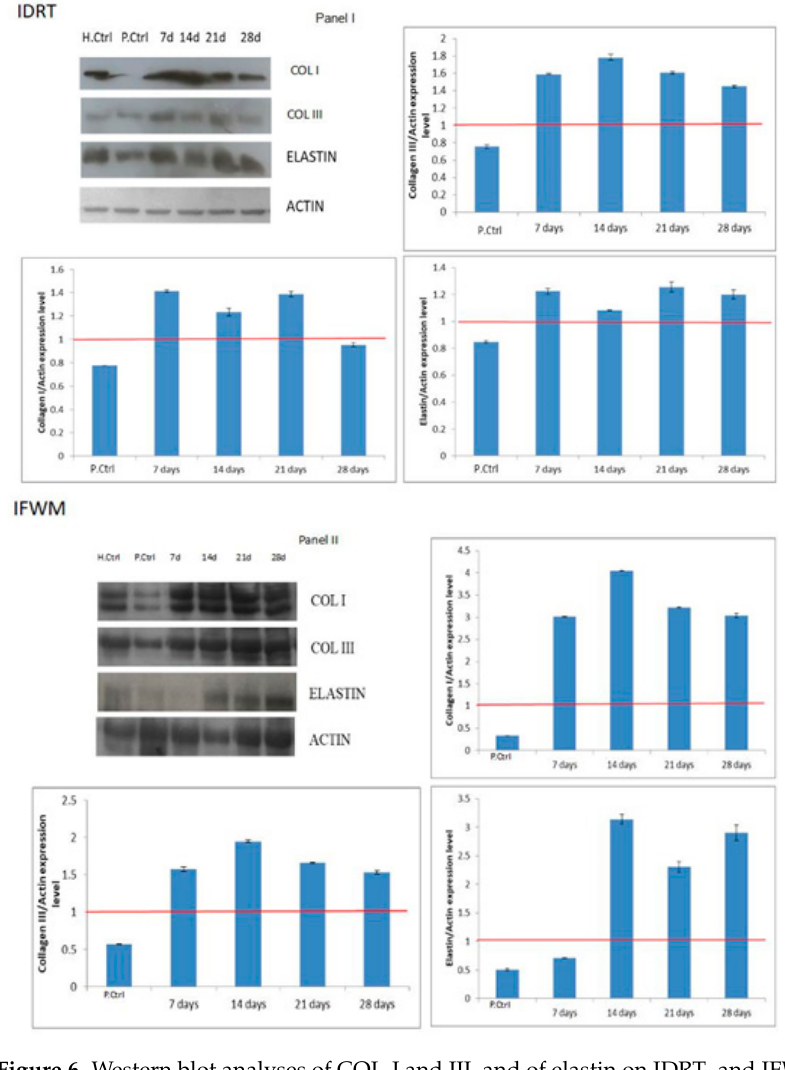
Figure 6. Western blot analyses of COL-I and III, and of elastin on IDRT- and IFWM-treated lesions during the post-surgical follow-up and relative controls. ( Panel I ) Western blot analyses on IDRT- treated lesions at different post-surgical time points, and on relative controls. H.Ctrl (Healthy Control) represents the sample withdrawn in the healthy part of the skin. P.Ctrl (Pathological Control) represents the sample withdrawn in the lesion before IDRT application. ( Panel II ) Western blot analyses on IFWM-treated lesions at different post-surgical time points, and on relative controls. H.Ctrl (Healthy Control) represents the sample withdrawn in the healthy part of the skin. P.Ctrl (Pathological Control) represents the sample withdrawn in the lesion before IFWM injection.